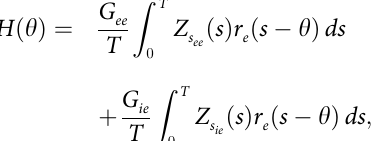
S1 Fig. Illustration of the resynchronization for large delay. A-B-C) Spiking activity obtained from simulations of the full spiking network. The black dots illustrate the spiking activity of the first network and the colored dots the activity of the second network. D) Bifurca- tion analysis. The circles are filled for stable fixed point and empty for the unstable points, red dots represent the illustrations parameters taken for the panels A-B-C. Parameters: N